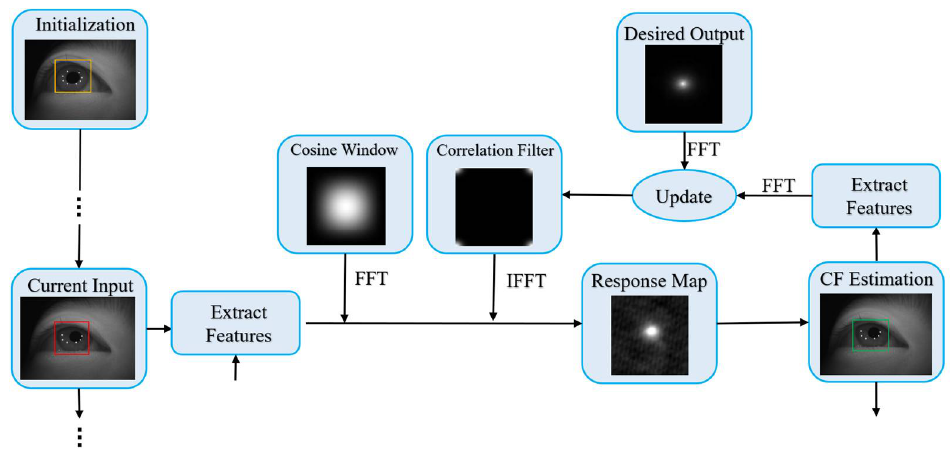
Figure 3. Flowchart of pupil tracking with KCF.